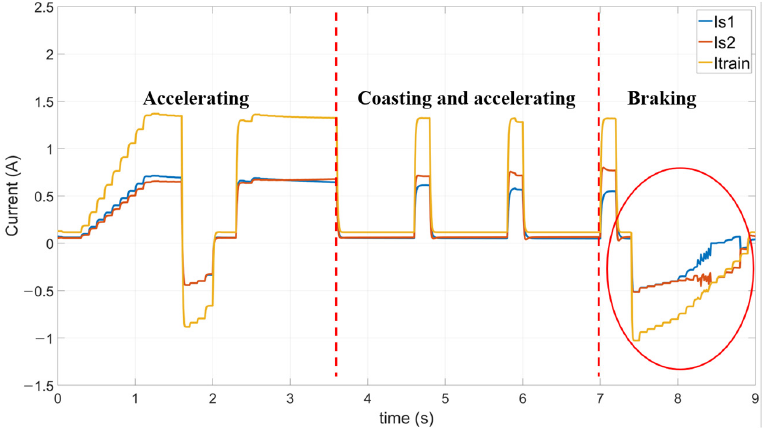
Figure 8. Simulation results for current distribution during train operation.